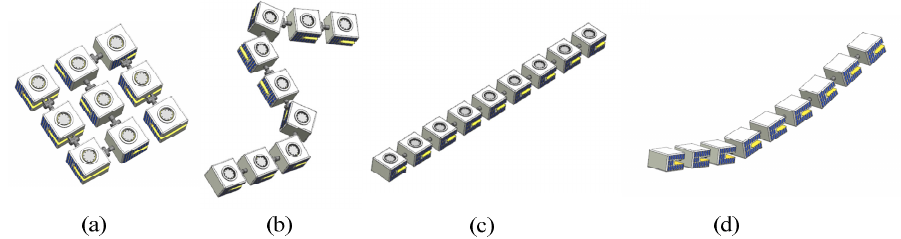
Figure 3. Configurations of SMSRS from the folded state to unfolded state and work state. ( a ) Folded state, ( b ) Unfolding, ( c ) Unfold state, ( d ) Work state.